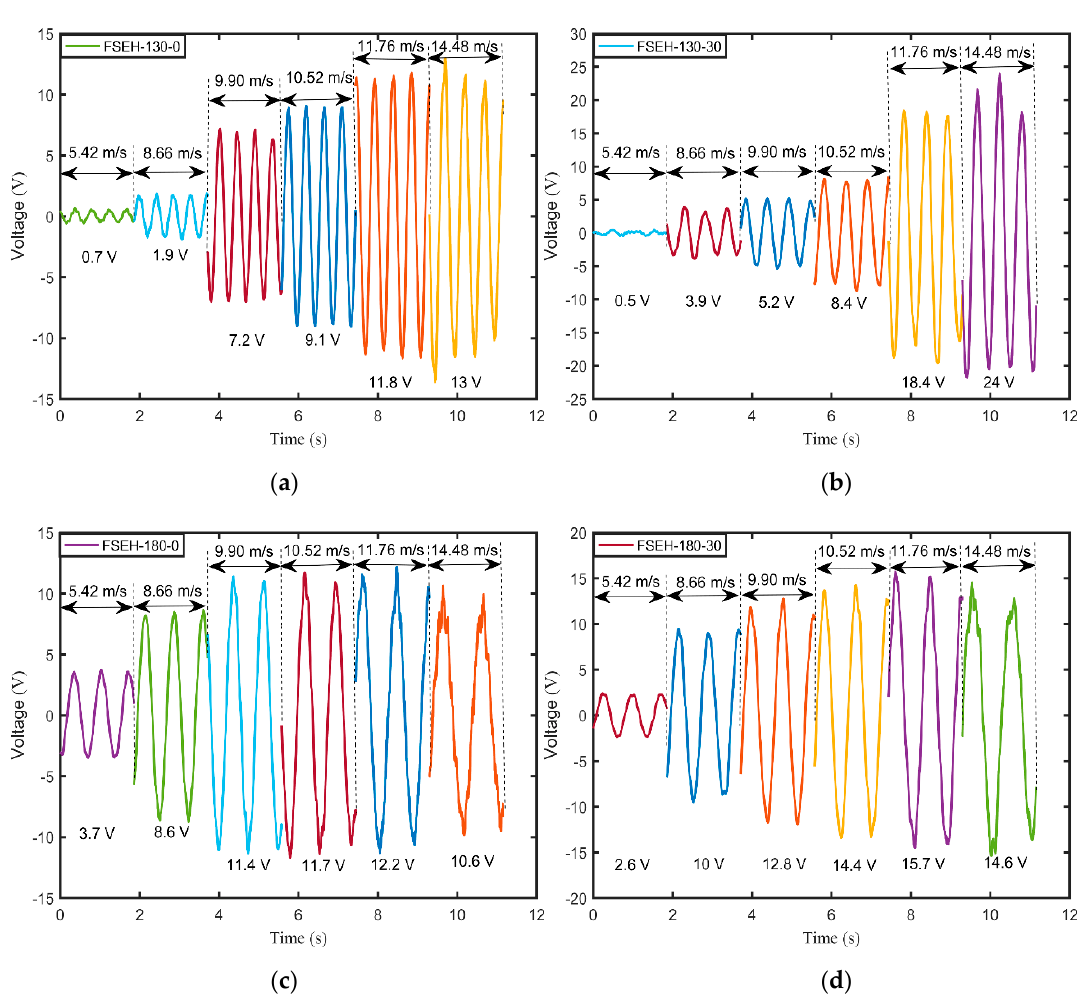
Figure 7. Variation of output voltage with time at various airflow velocities for different harvesters: ( a ) FSEH-130-0; ( b ) FSEH-130-30; ( c ) FSEH-180-0; and ( d ) FSEH-180-30.